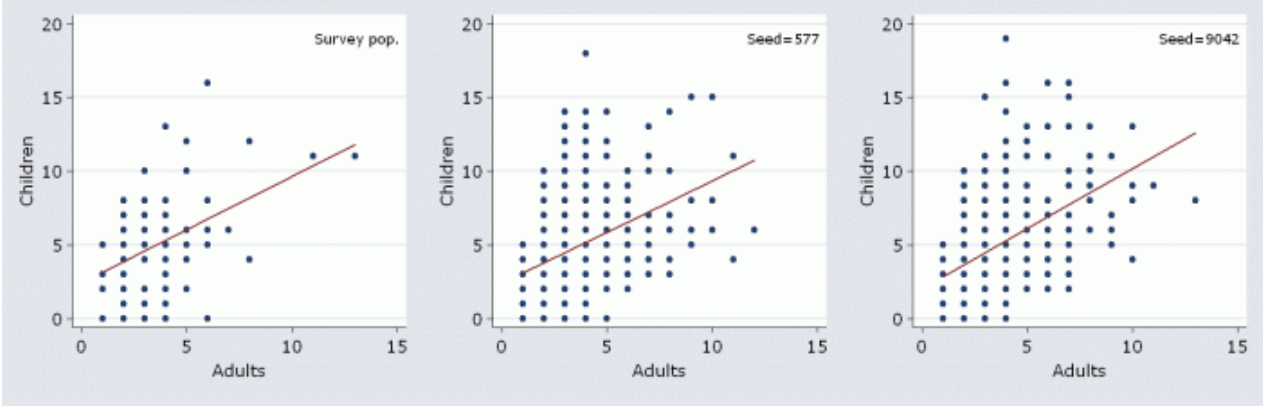
Fig. 9. Scatter plots correlating the number of children and adults, with regression line.